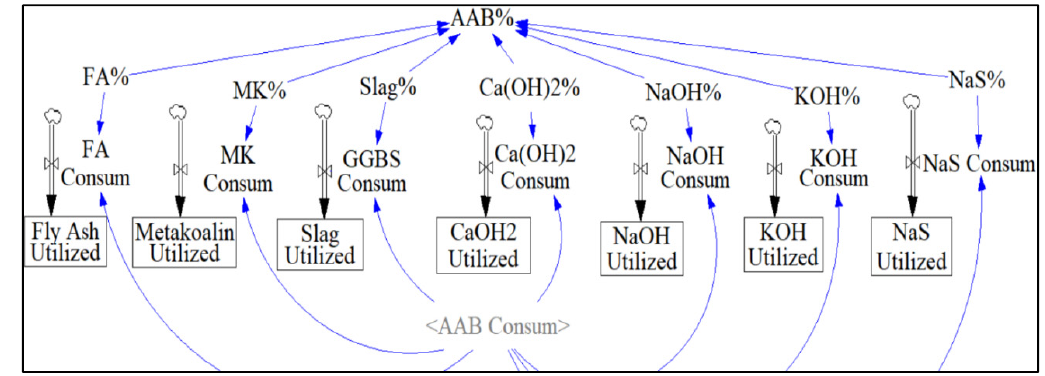
Figure 10. AAB Composition Sector.